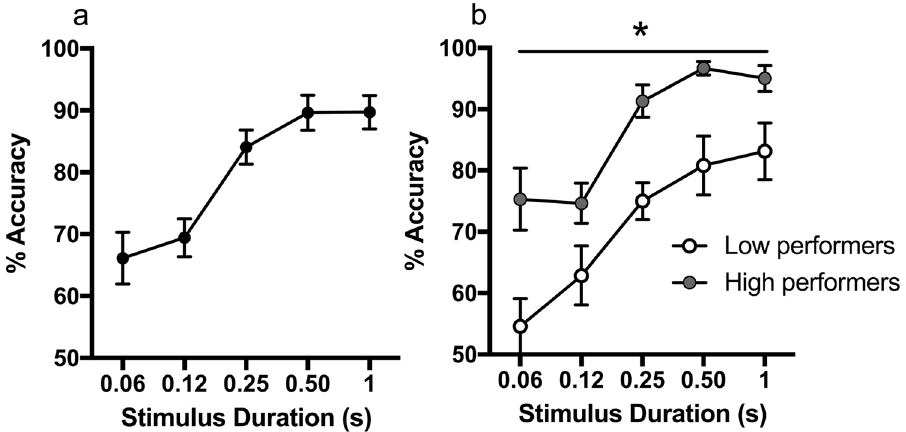
Figure 1. Manipulating accuracy by reducing signal duration. ( a ) Decreasing signal duration led to a reduction in accuracy on the signal detection task where 50% is chance accuracy ( N = 18). ( b ) There was a significant difference between low and high performance groups ( n = 8–10) across all signal durations, * p <